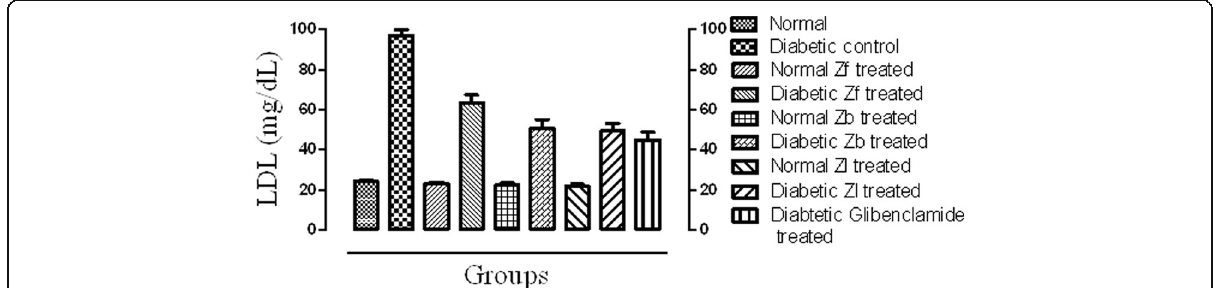
Fig. 3 Effect of extracts and standard drug on serum low density lipoproteins (mg/dl) level of normal and alloxan monohydrate induced diabetic